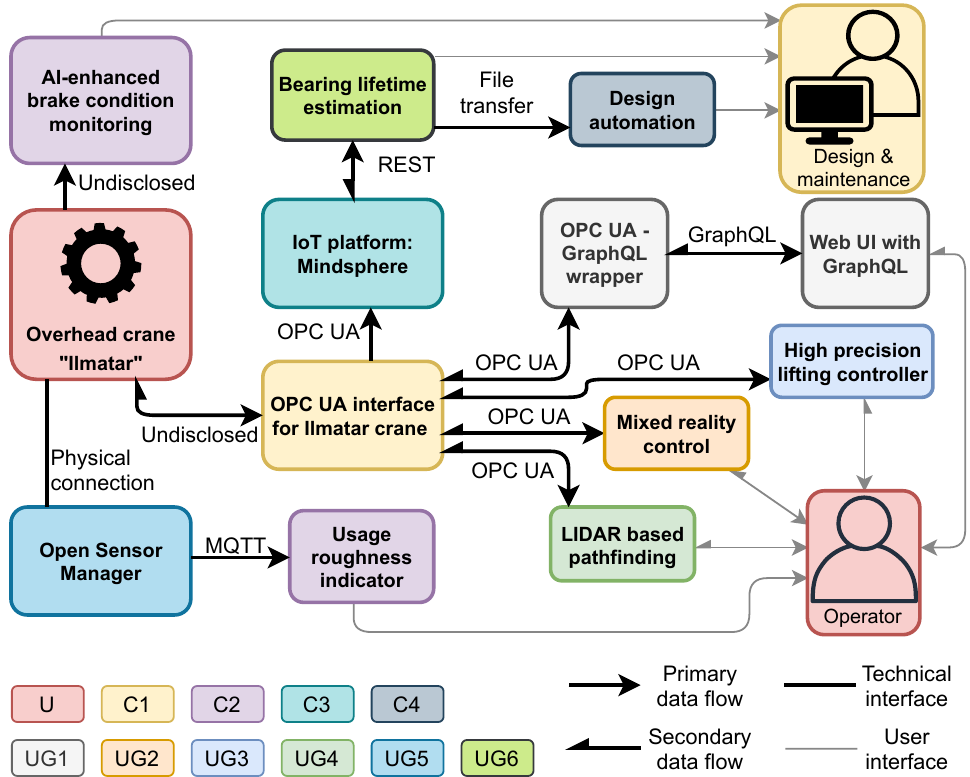
Figure 13. A case visualization of the API-based business network framework: The components of the Ilmatar DT are colored by the organization in charge of their operation. U: university in general, C1-C4: companies, UG1-UG6: university